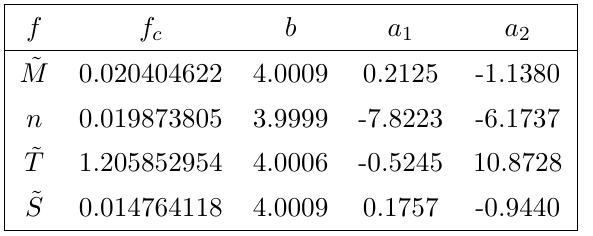
Table 1 . Fit parameters for the function f ( Q ) = f c physical quantities and Q = L A =L . The (cid:12)t parameters were determined using all data points with Q . 0 : 02.